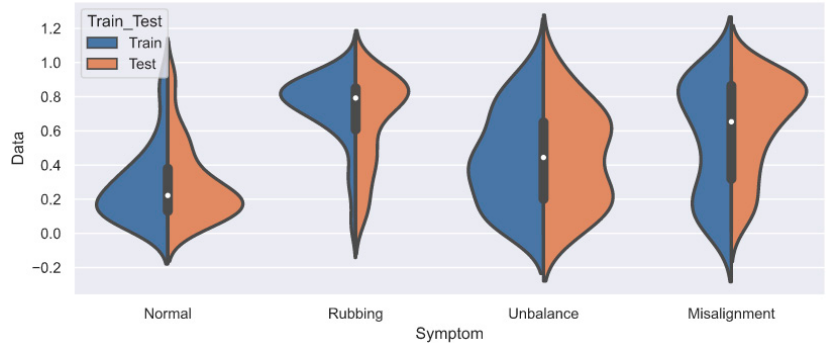
Figure 11. Violin plot result proposed in this paper using Fault Score CAM.